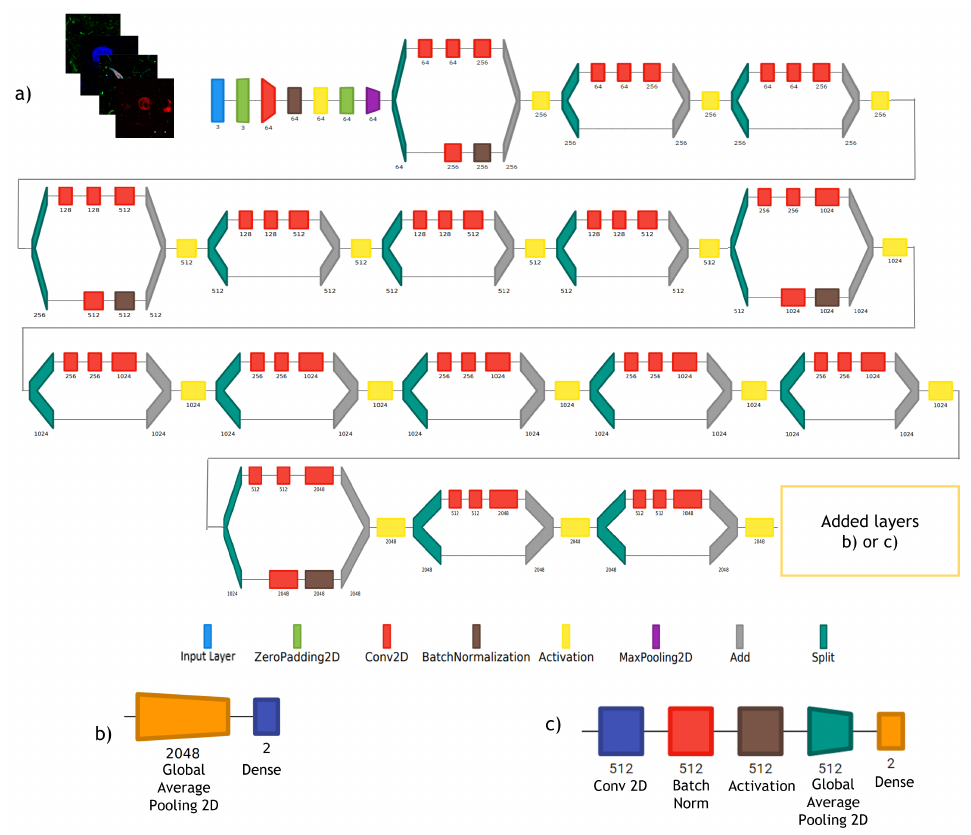
Figure 3. ResNet-50-based architecture designs used in this study. ( a ) Base model of ResNet-50 from Keras until the last activation layer of the last convolution. ( b ) Layers added at the end of the base model for development of ResNet-IFT. ( c ) Layers added at the end of the base model for development of ResNet-IFTF. (Diagrams of the architectures were developed using Net2Vis tool for visualizing Deep Learning